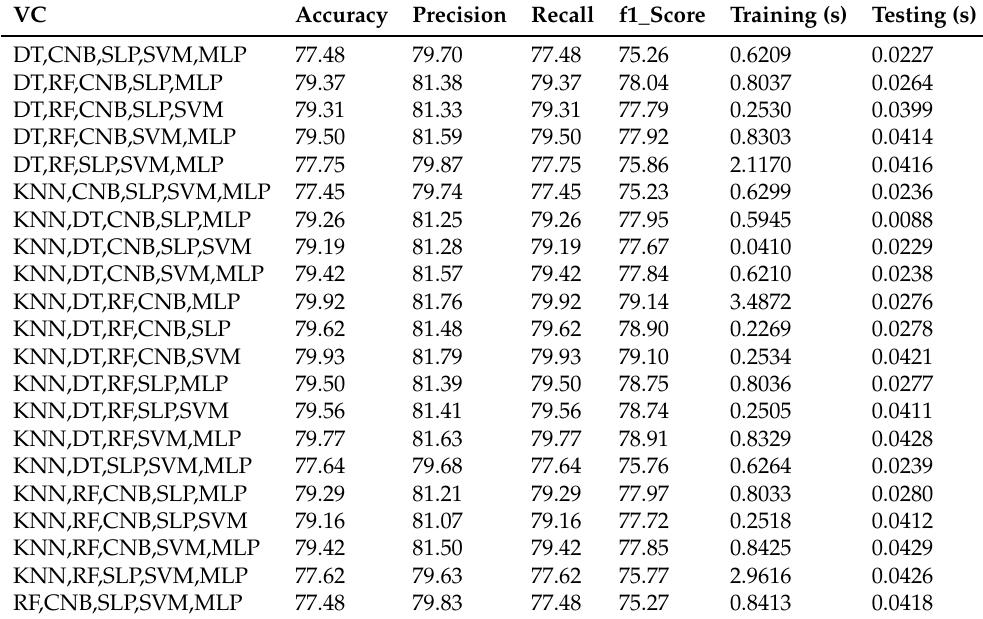
Table 6. Ensemble Learning Algorithms (combinations of five